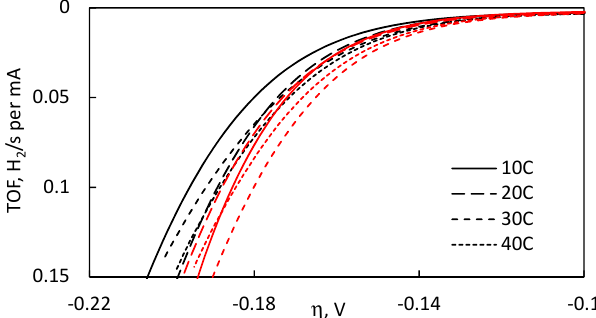
Figure 13. TOF values plotted as a function of overpotential for MoS 2 films, electrodeposited without and with NaH 2 PO 2 . (Red lines correspond to samples, deposited with NaH 2 PO 2 ).